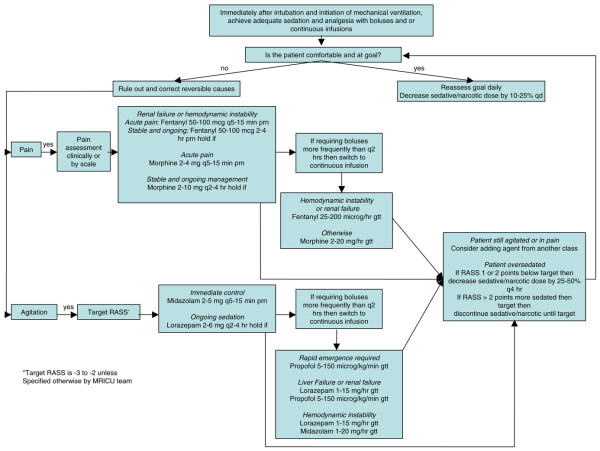
The sedation algorithm used in this study. gtt, drop; MRICU, medical respiratory intensive care unit; prn, as necessary (pro re nata); q, every; qd, each day (quaque die); RASS, Richmond Agitation-Sedation Scale.